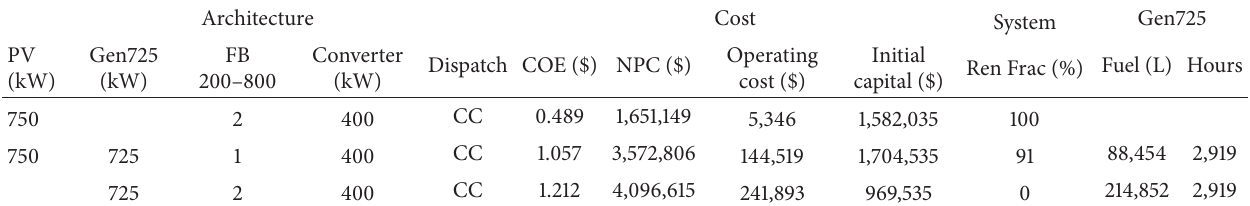
Table 4: HOMER simulation result showing sensitivity case only.